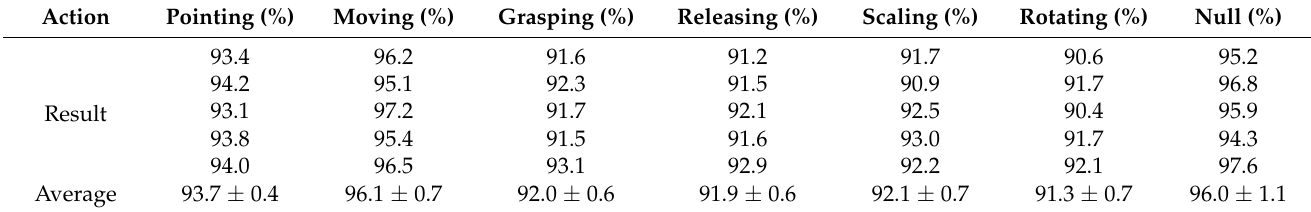
Table 4. The recognition accuracy on HoloLens ARAAT